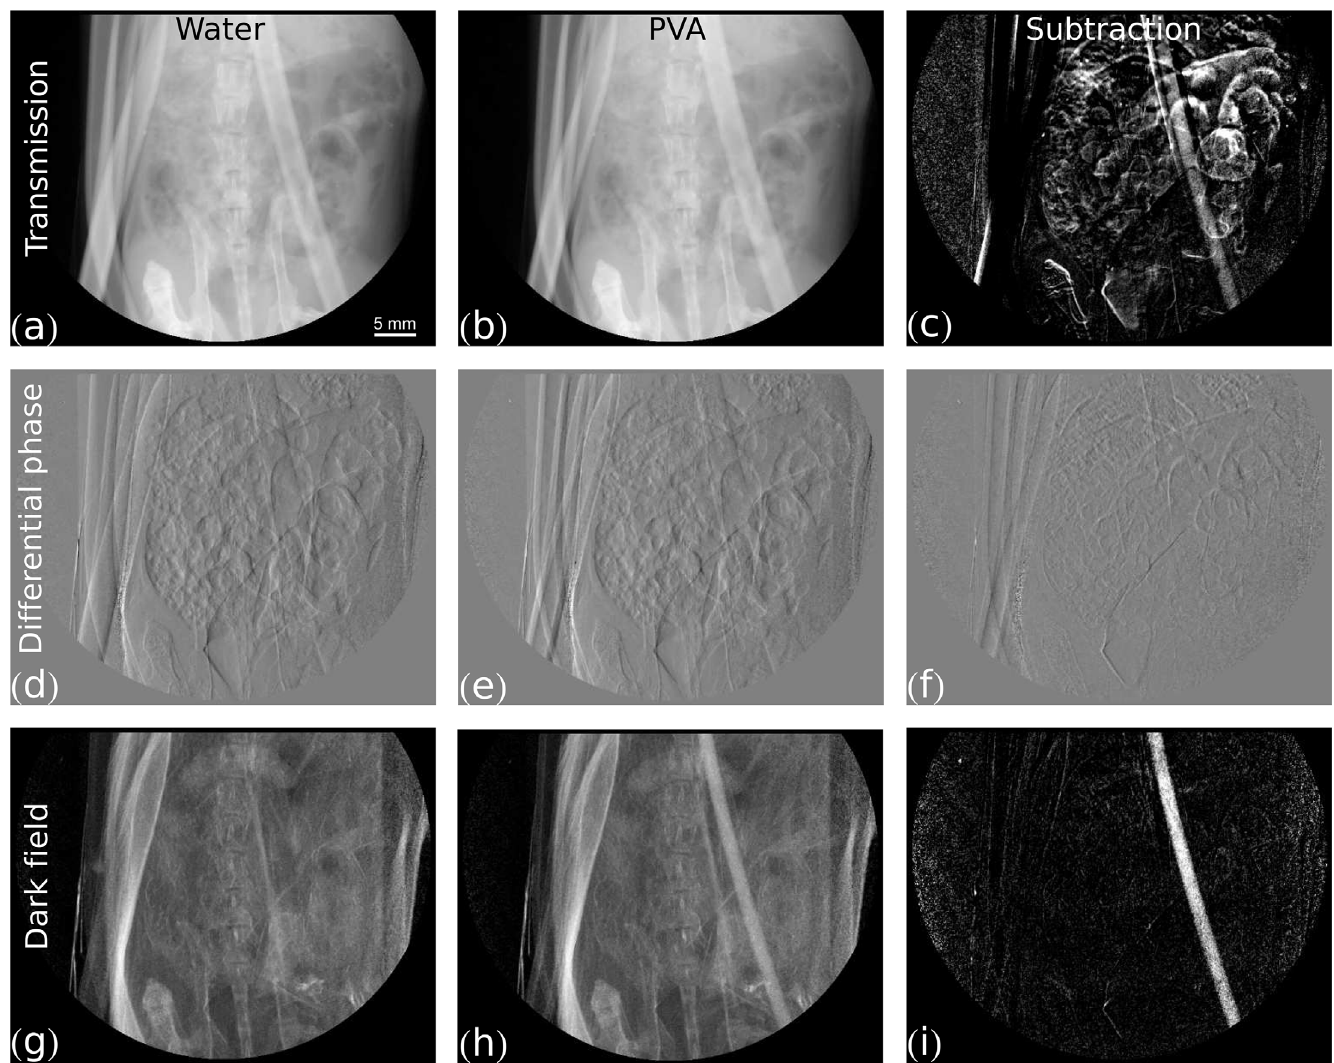
Fig 3. Measurement of pure PVA bubbles contrast agent. Grey value scaling is given in brackets. The first column shows the same image with the tube filled with water for three different contrast modalities: (a) transmission [0, 0.9], (d) differential phase [ (cid:1) p the same image with the tube fi lled with pure PVA-microbubbles suspension in three different modalities: (b) transmission [0, 0.9], (e) differential phase [ (cid:1) p p ], (h) dark fi eld [0, 1.0]. The third column shows the subtraction of the image with contrast agent (second column) from the image with water ( fi rst column) for 2 three different contrast modalities: (c) transmission [0, 0.04], (f) differential phase [ (cid:1) p